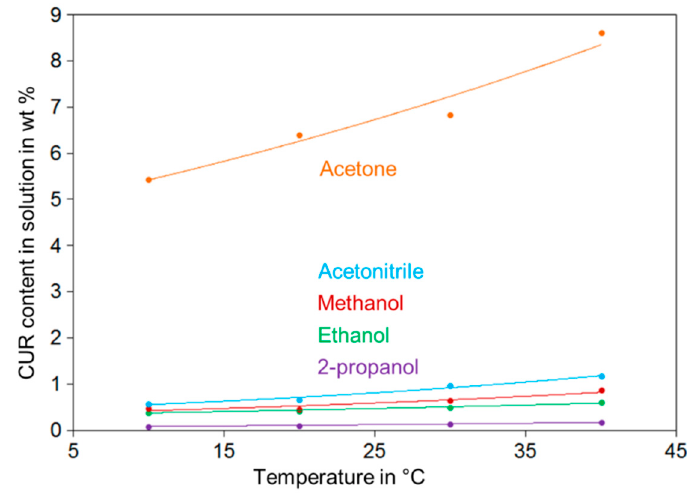
Figure 3. Solubility behavior of CUR in acetone, acetonitrile, methanol, ethanol and 2-propanol. Symbols represent experimental data, fitted curves just serve as guide to the eyes.